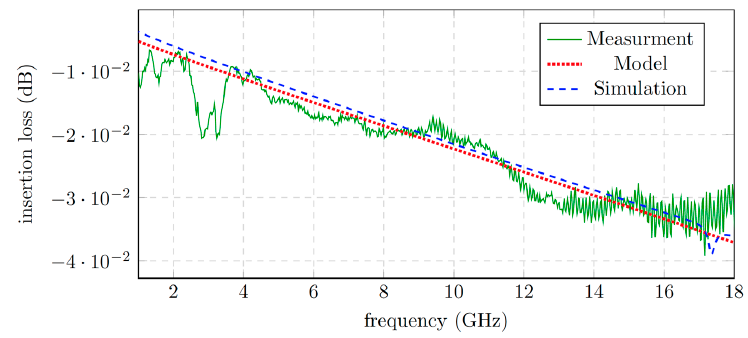
Figure 15. Insertion loss: Measurement vs. Model vs. Simulation.